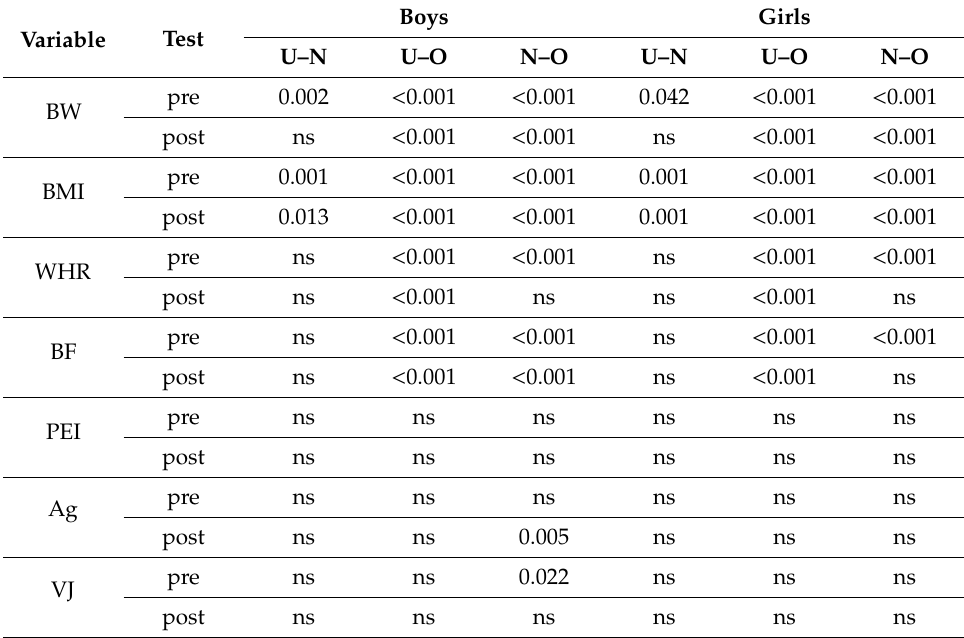
Table 2. P-values from Tukey’s test for di ff erences between adolescents in di ff erent BMI status groups in pre- and post-tests (only statistically significant